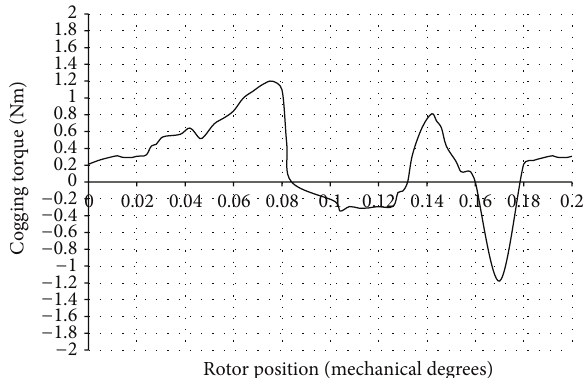
Figure 8: Cogging torque waveform after changing magnet pole arc width.